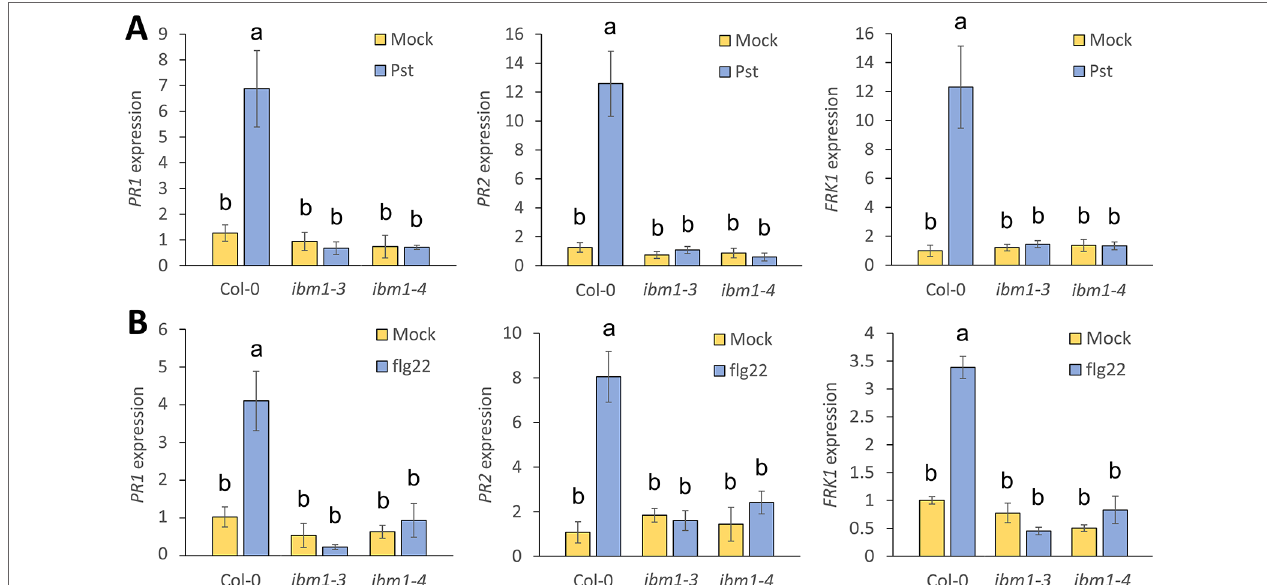
FIGURE 2 | Up-regulation of immunity marker genes is compromised in ibm1 mutants. (a) Up-regulation of defense marker genes after Pst DC3000 inoculation. Fourteen-day-old seedlings were floated in liquid 1/2 Murashige and Skoog (MS) for one night before inoculation with 10 6 cfu/ml Pst DC3000 for 3 h. Equivalent volume of 10 mM MgSO 4 was used as mock control. Transcript levels of PR1 , PR2 , and FRK1 were determined by quantitative real-time PCR and normalized to UBQ10 (Col-0 mock as defined value of 1). Values represent average ± SEM from three independent experiments each with three technical repeats (N = 9). Letters denote significant differences based on a one-way ANOVA with post hoc Tukey honestly significant difference (p < 0.05). (B) Up-regulation of defense marker genes after flg22 treatment. Fourteen-day-old seedlings were floated in liquid 1/2 MS for one night before treatment with 100 nM flg22 for 3 h. Equivalent volume of water was used as mock control. Gene expression of PR1 , PR2 , and FRK1 were evaluated and analyzed as in A.